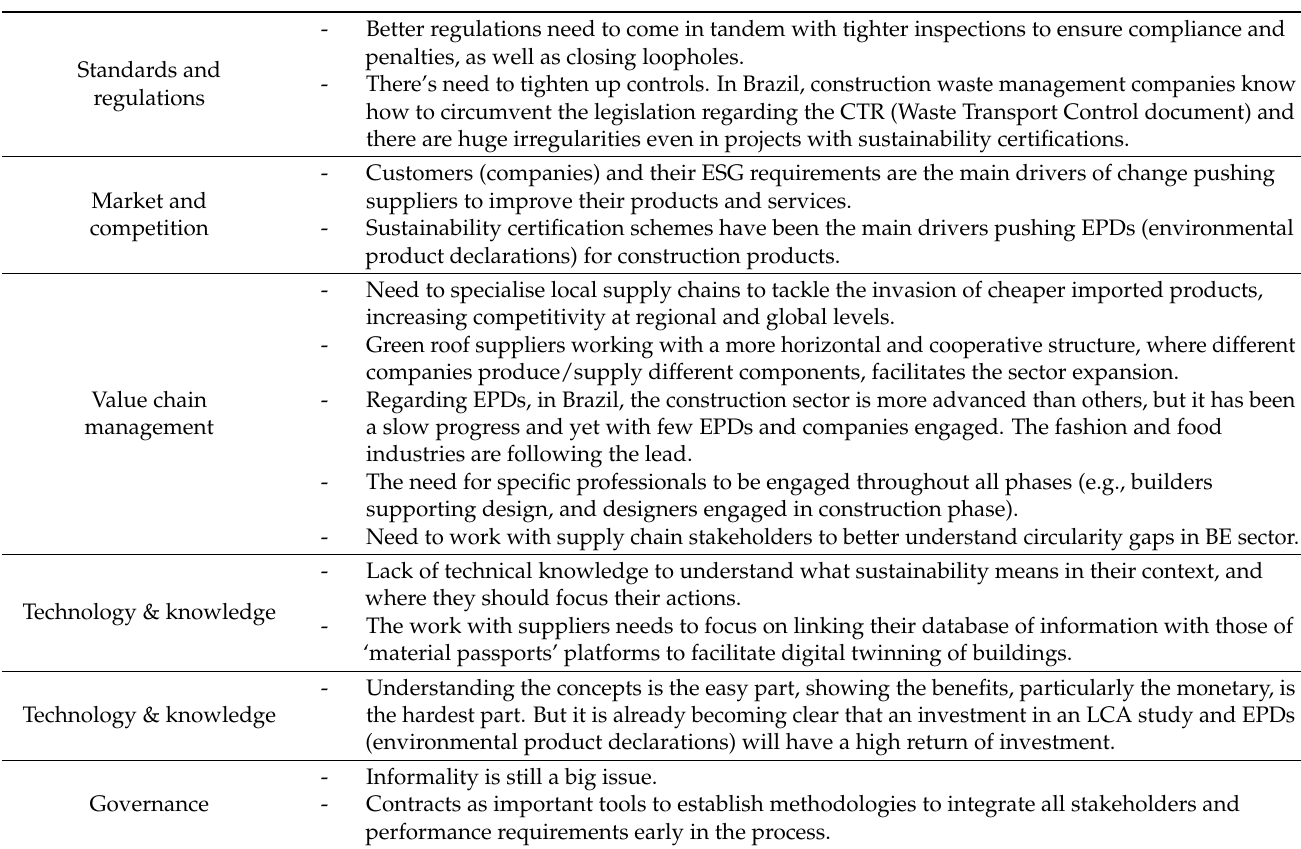
Table 5. Perceptions and possible pathways for a more integrated supply